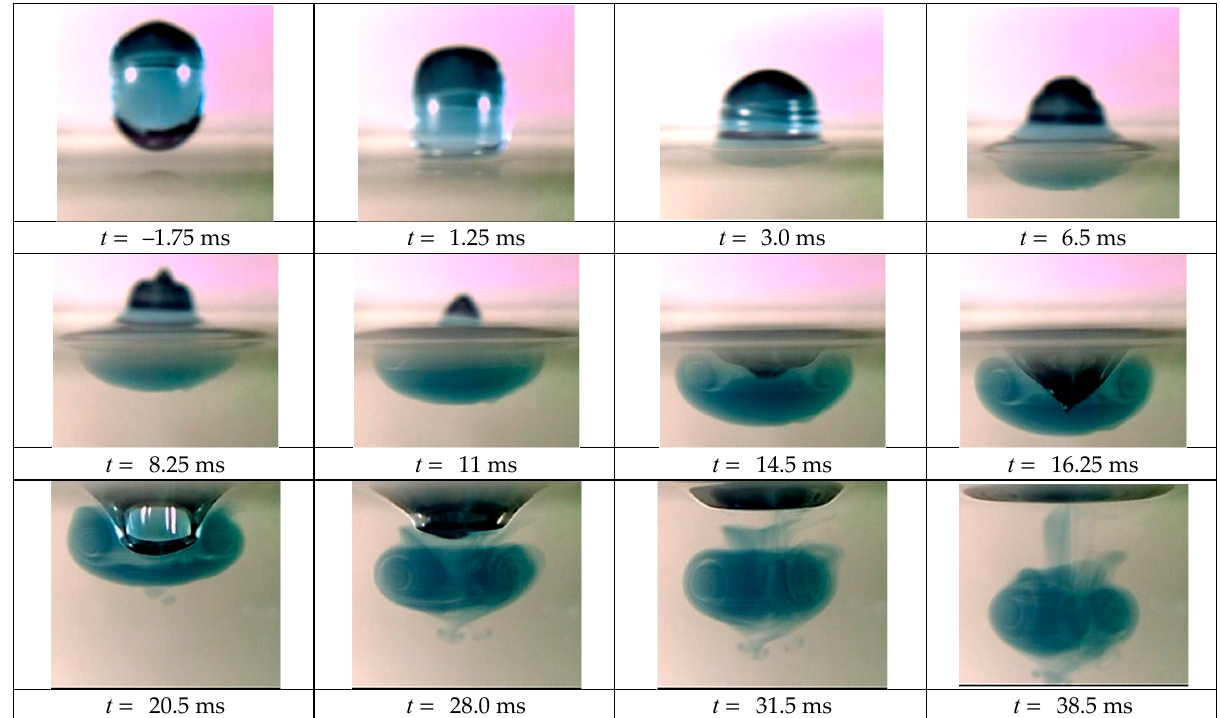
Figure 3. Side view of the flow produced by slow falling drop of an aqueous ink solution diluted at ratio 1:1000 ( ρ = 1.0 g/cm 3 , σ = 73 g/s 2 , µ = 0.01 g/cm · s and in Figures below) coalescing with tap water ( D = 4.3 mm, U = 0.34 m/c, E σ = 4 mkJ, E k = 2.24 mkJ, Re = 1460, Fr = 2.8, We = 6.7, Bo = 2.5, Oh = 0.0018, R E = E k / E σ = 0.57, R w = 7.8 × 10 − 7